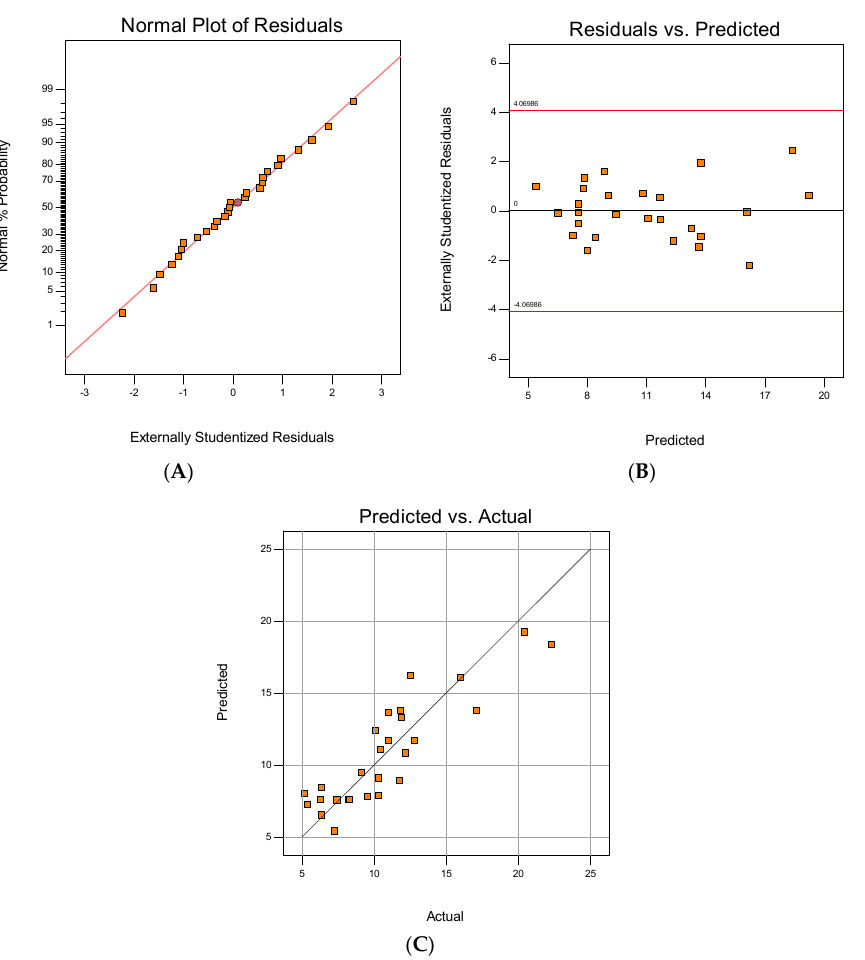
Figure 8. Diagnostic plots: ( A ) normal plot of residuals, ( B ) residuals vs. predicted and ( C ) predicted vs. actual.